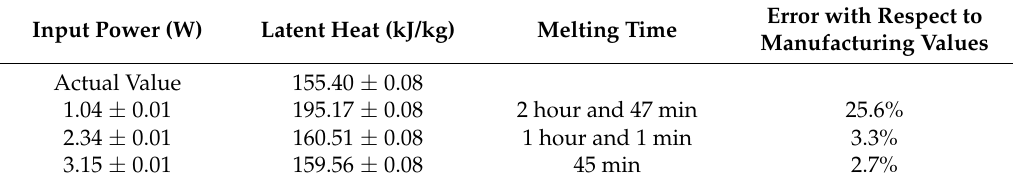
Table 2. Values of latent heat capacity and melting time of the PCM.